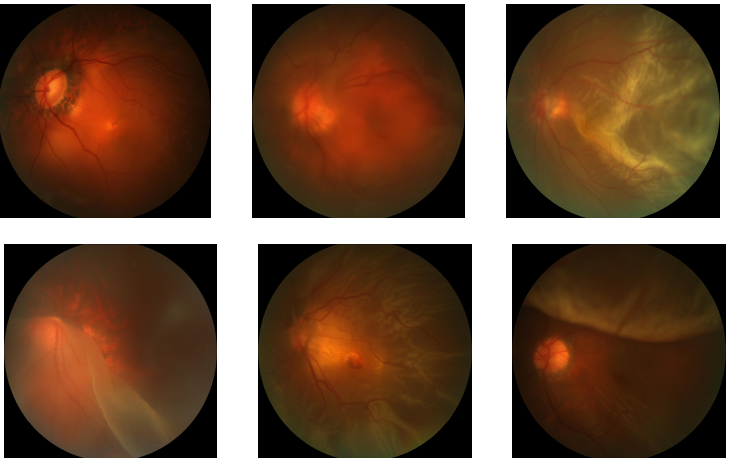
Figure 3. False-negative PM cases of a model trained with publicly available fundus images labeled in an active learning manner. Images with retinal detachment were mis-classified to non-PM as they were not included enough in the mined labels.